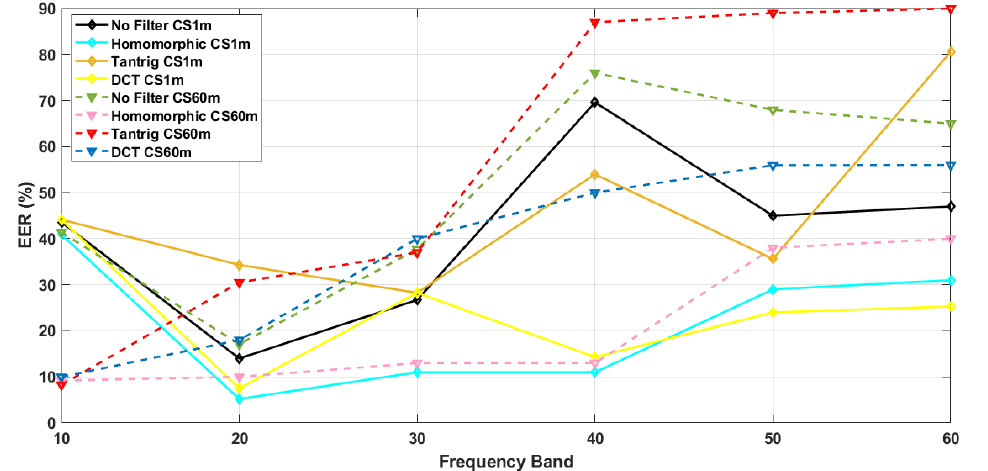
Figure 4. The effects of BLPOC FB variations on filtering operations in CS face